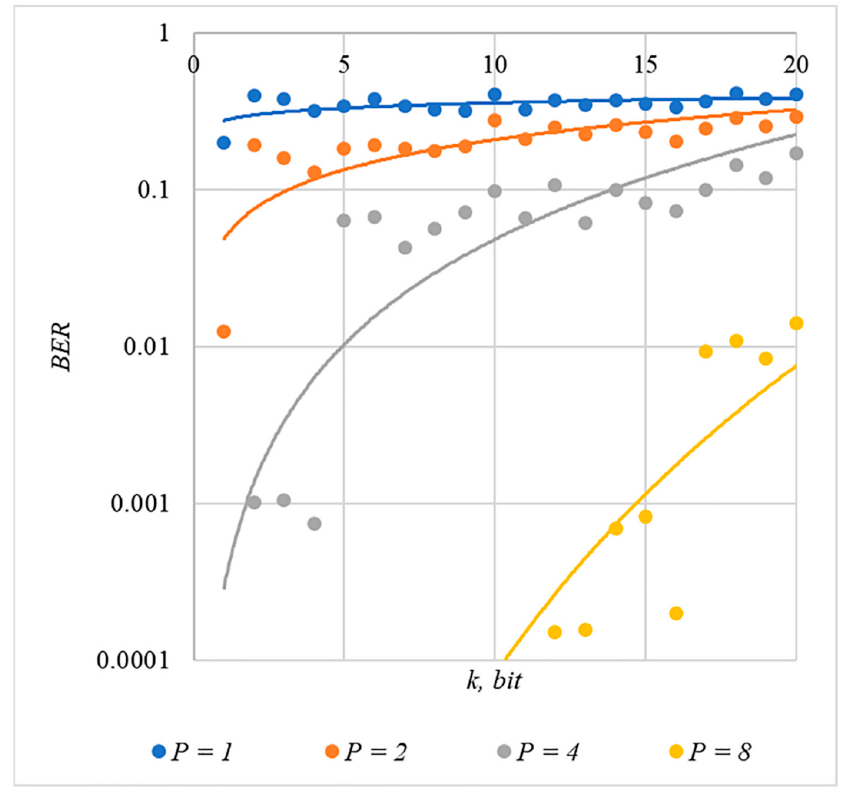
P rule for generating chip codes № 3.